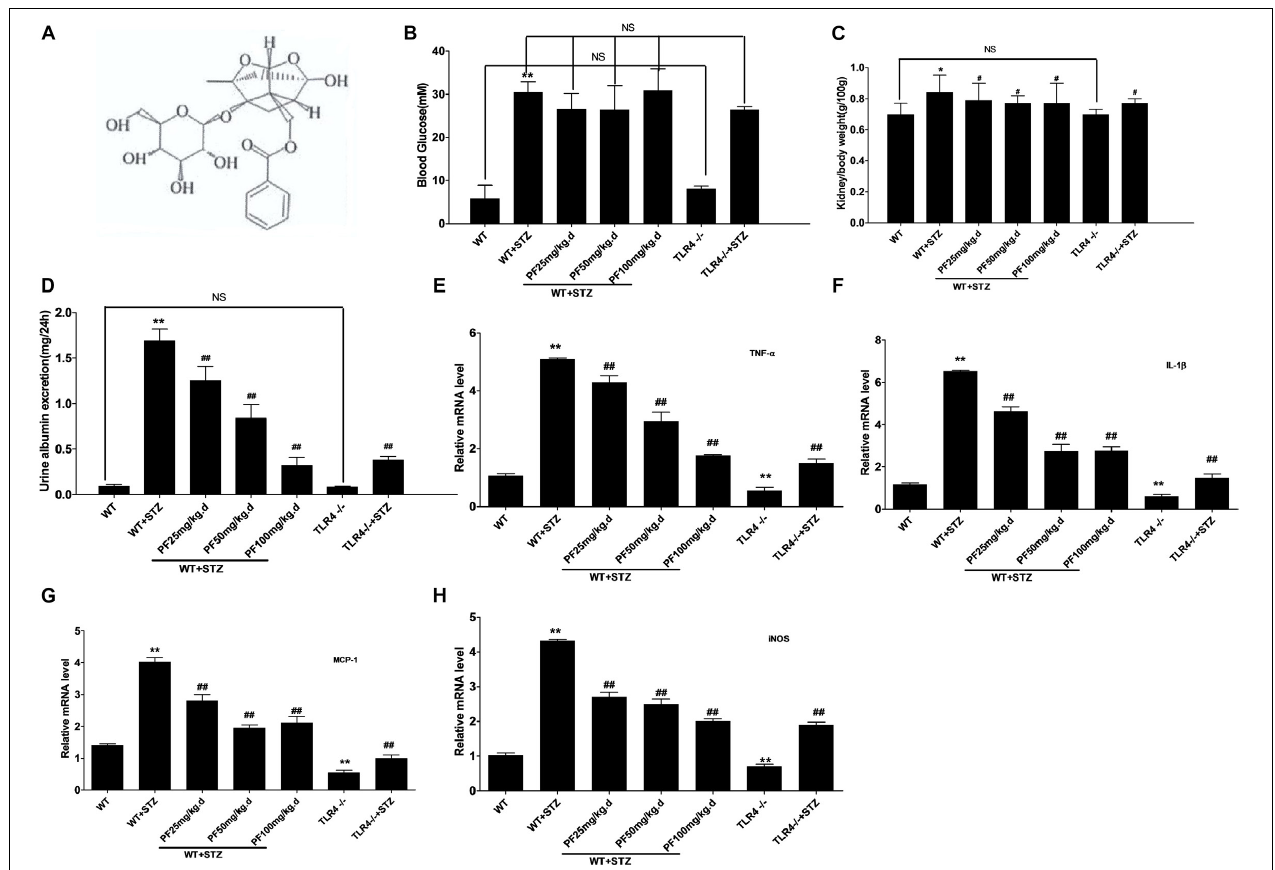
FIGURE 1 | PF improved clinical symptoms and alleviated inflammation. (A) The chemical structure of paeoniflorin. (B) Blood glucose levels. (C) Kidney /body weight. (D) Urine albumin excretion. Data were detected and are presented as the mean ± SD of at least three independent experiments. n = 12 in each group. NS: not significant; ∗ p < 0.05 and ∗∗ p < 0.01 vs. WT; # p < 0.05 and ## p < 0.01 vs. WT+STZ. (E–H) Expression of iNOS, TNF- α , IL-1 β , and MCP-1 in renal tissue. The results are represented as the mean ± SD of at least three repeated experiments. ∗ p < 0.05 and ∗∗ p < 0.01 vs. WT; # p < 0.05 and ## p < 0.01 vs. WT+STZ; NS, not